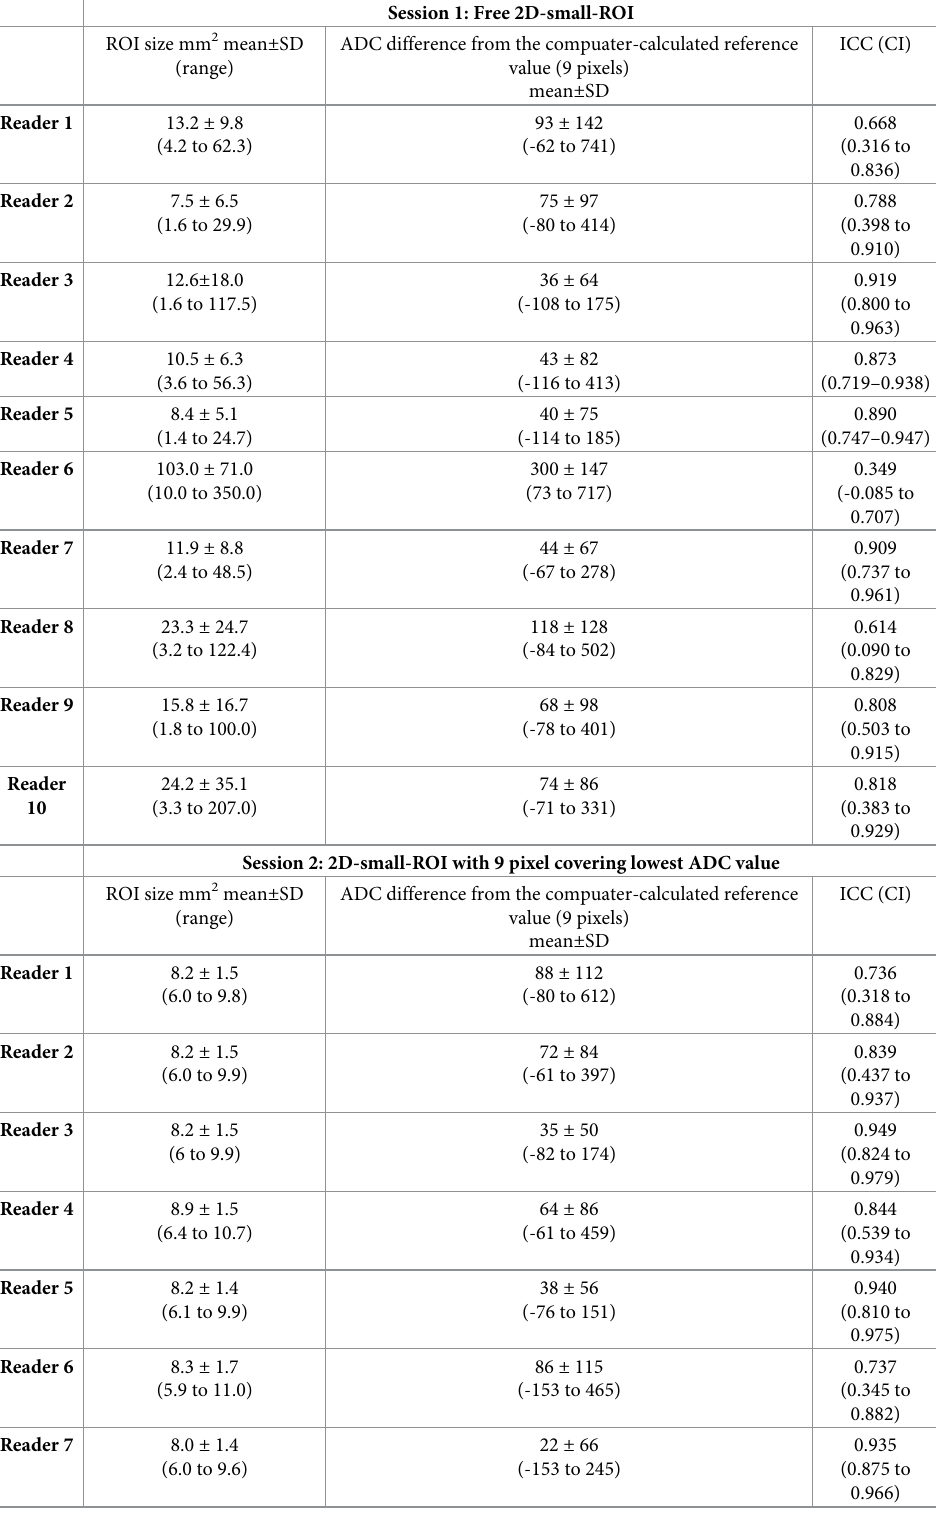
Table 1. The results of the multi-reader